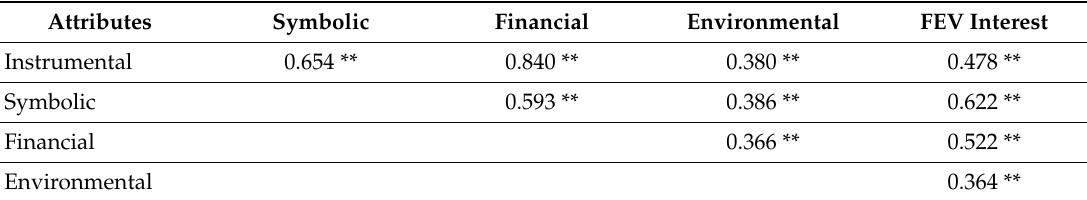
Table 5. Bivariate correlations coe ffi cients between the evaluations of the four di ff erent attributes and interest in purchasing an FEV.